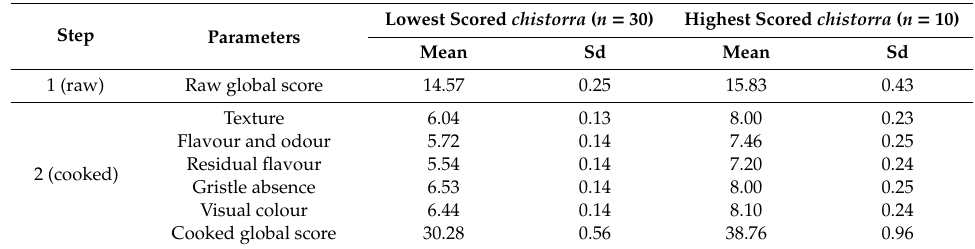
Table 1. Means and standard deviation (SD) of sensory attribute values obtained for chistorras in steps 1 and 2 of the contest. Data were grouped in the 10 best scored and the 30 worst scored chistorras . Lowest Scored chistorra ( n = 30) Highest Scored chistorra ( n = Parameters